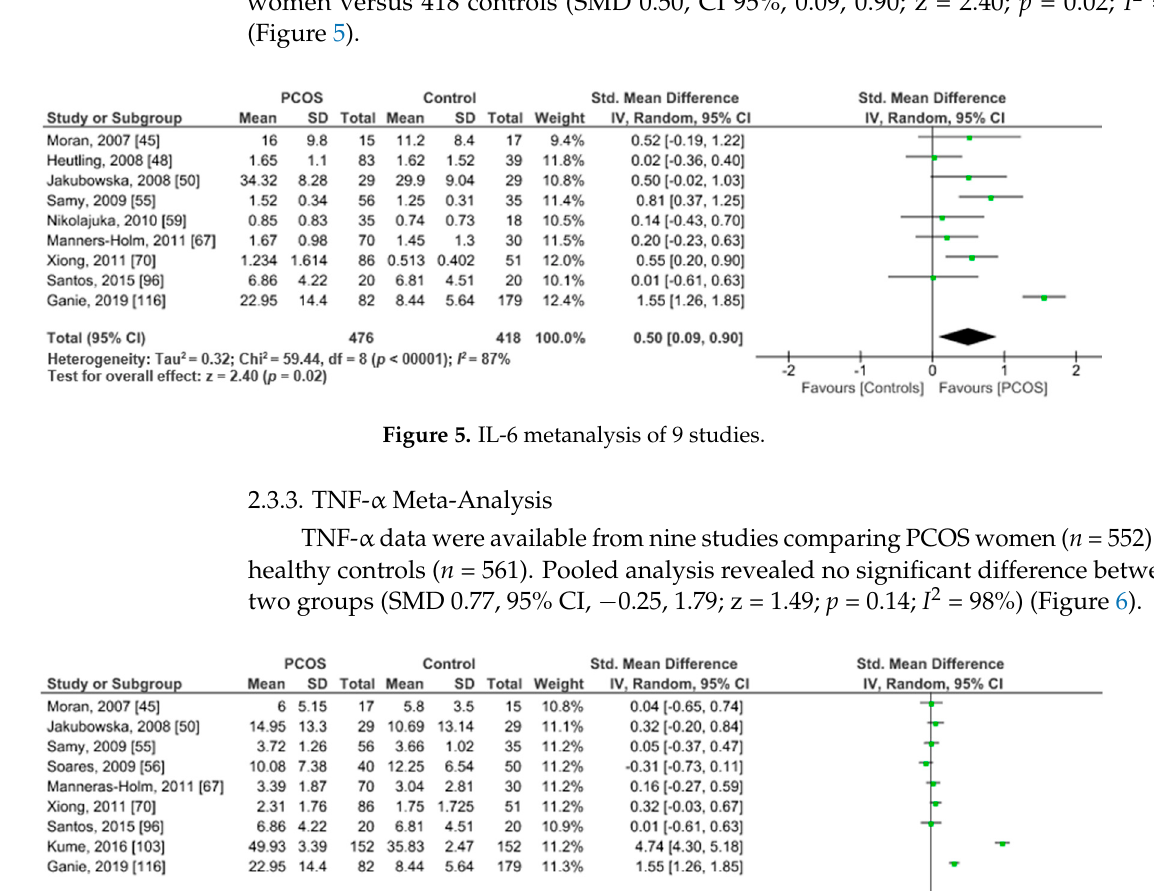
Figure 4. CRP subgroup analysis of 7 studies including obese women.